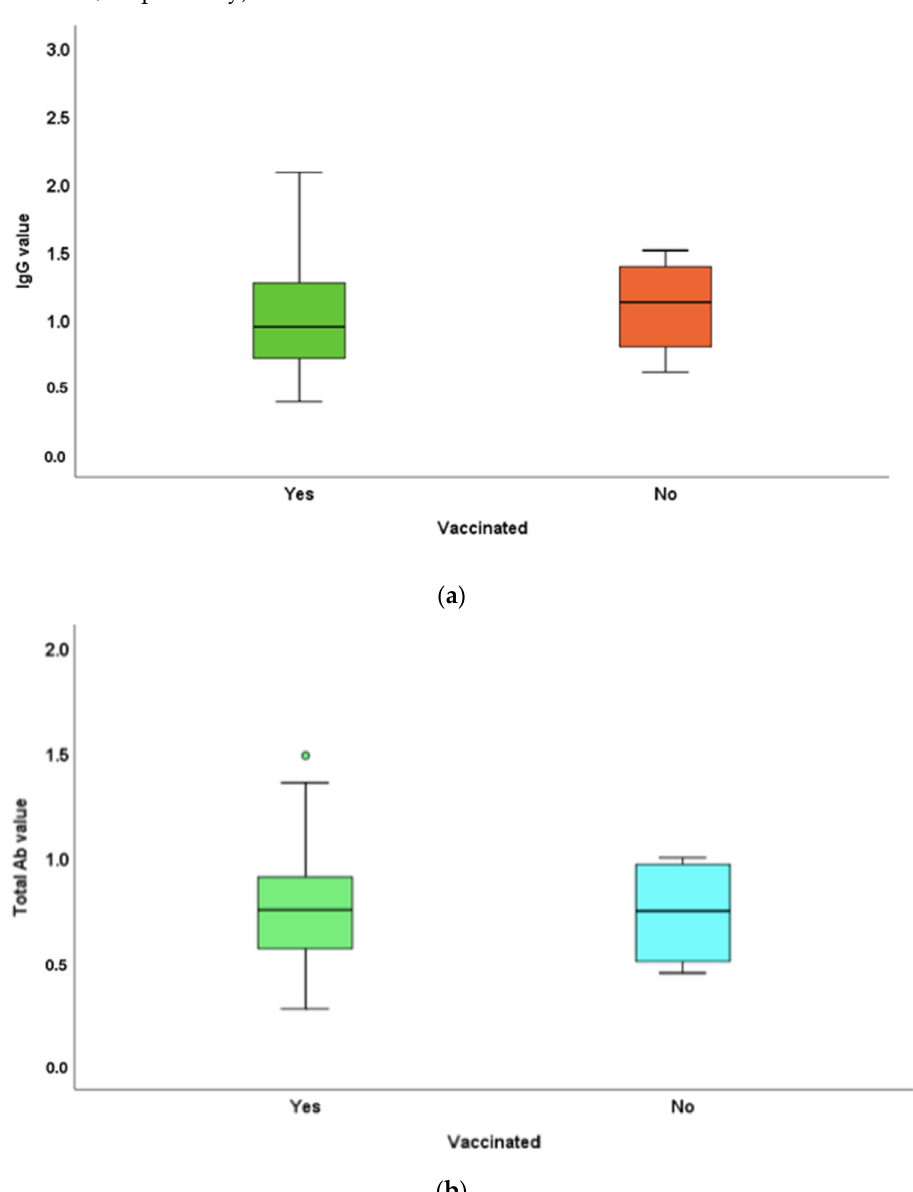
Figure 2. Mean IgG and total antibody titre differences between vaccinated and unvaccinated individuals in the saliva samples: ( a ) IgG titres in vaccinated and unvaccinated populations in the study were 1.02 ± 0.41 and 1.09 ± 0.39 g, respectively. ( b ) Total antibody titres in vaccinated and unvaccinated populations in the study were 0.75 ± 0.24 and 0.73 ± 0.27 g, respectively. IgG levels were slighter higher in the unvaccinated population, whereas total antibody levels were greater in vaccinated individuals. The differences in the antibody titres between the vaccinated and unvaccinated populations were not statistically significant ( p ‐ values = 0.65 and 0.92, respectively).